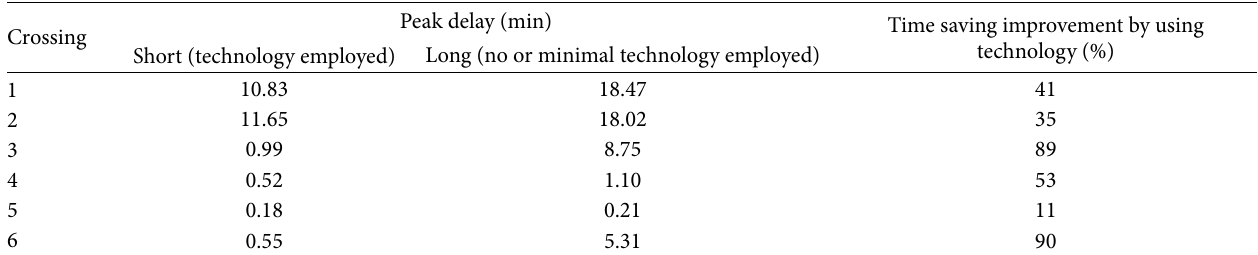
Table 5: Summary of peak vehicle